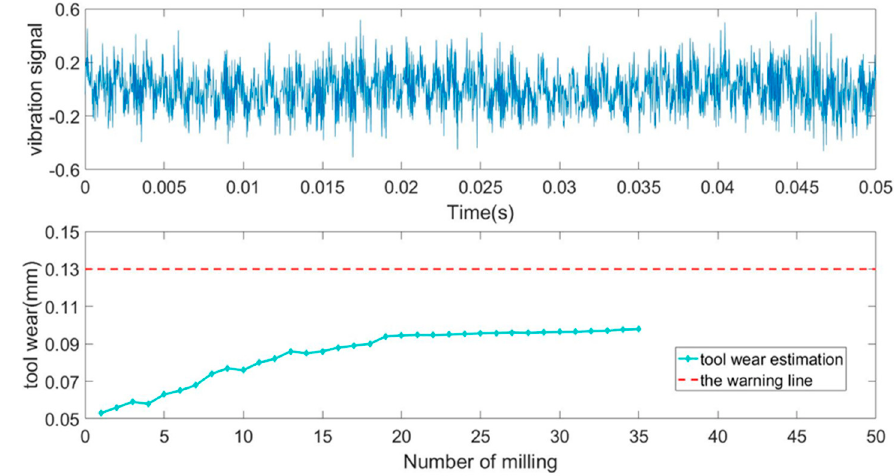
Figure 9. The tool wear real-time monitoring graph.